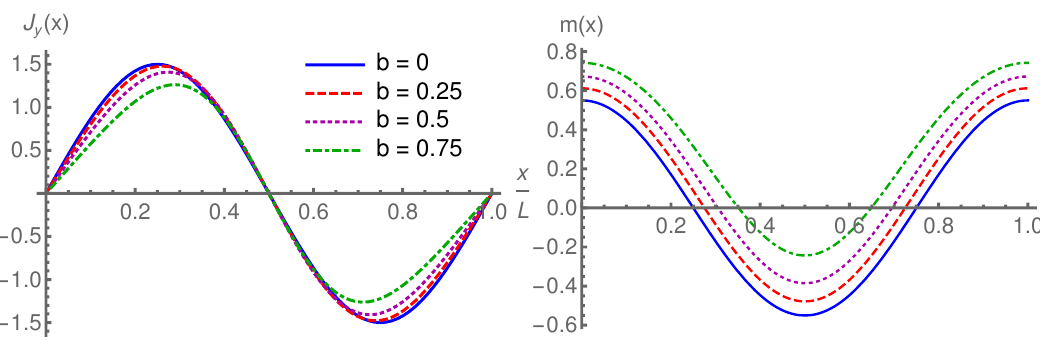
Figure 1 . The effect of magnetic field on the striped background at µ = 4 : (Left) The persistent transverse current J y ( x ) , and (Right) the magnetization density m ( x ) over a spatial wavelength. The blue, red dashed, magenta dotted, and green dot-dashed curves are the results at b = 0 , 0 . 25 , 0 . 5 , and 0 . 75 , respectively. We chose units here such that T 7 V 6 L 5